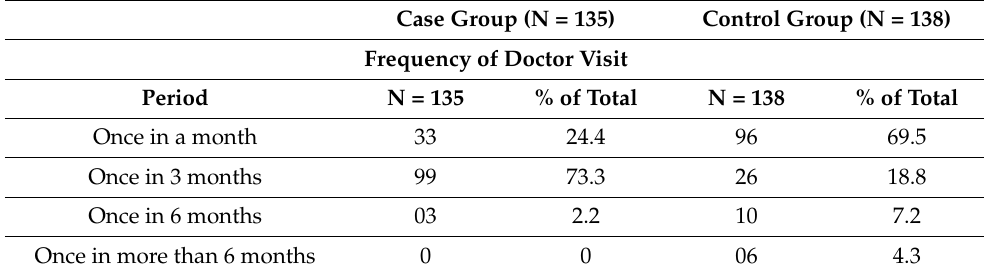
Table 2. Participants’ disease management practices in RCT (please refer to Supporting Excel Sheet #S2 containing the statistical test